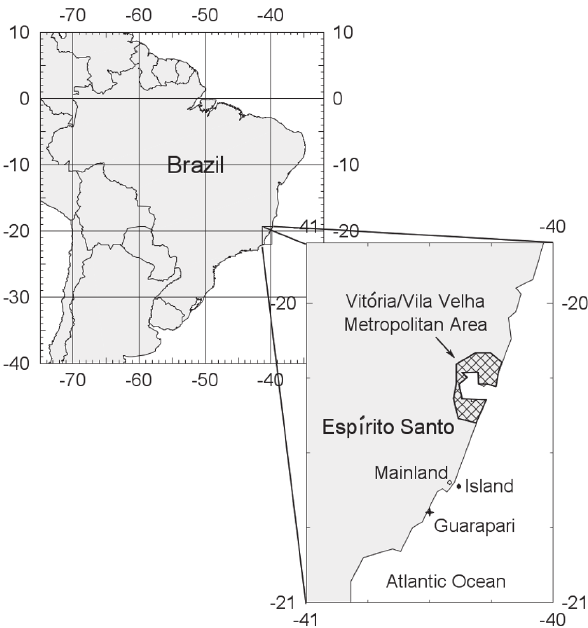
Figure 1. Map of the study area in Brazil, with detail of the sam- pling locations in the state of Espírito Santo, Brazil. The two small circles just north of the municipality of Guarapari are where the study took place (marked with mainland and